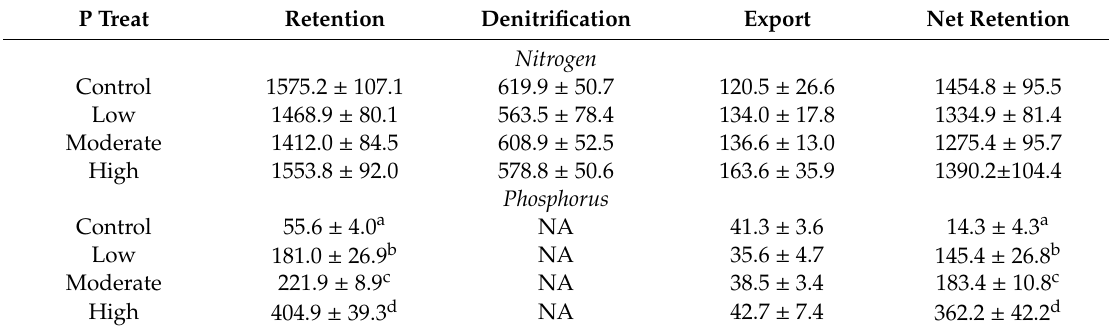
Table 5. Mean ( ± SE) mass balance estimates (mg m − 2 ) for net N and P retention in vegetated mesocosms across P enrichment treatments. Letters represent significant di ff erences between treatments based on least square mean post-hoc tests ( P <